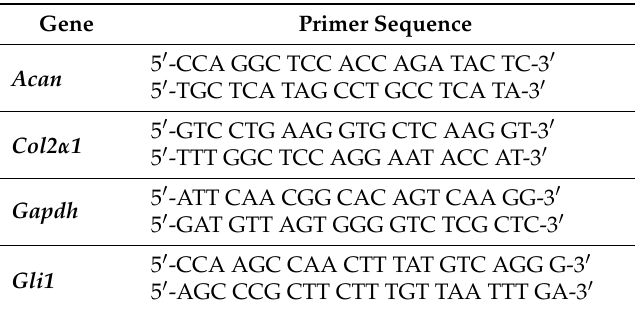
Table 2. Primer sequences used for real-time